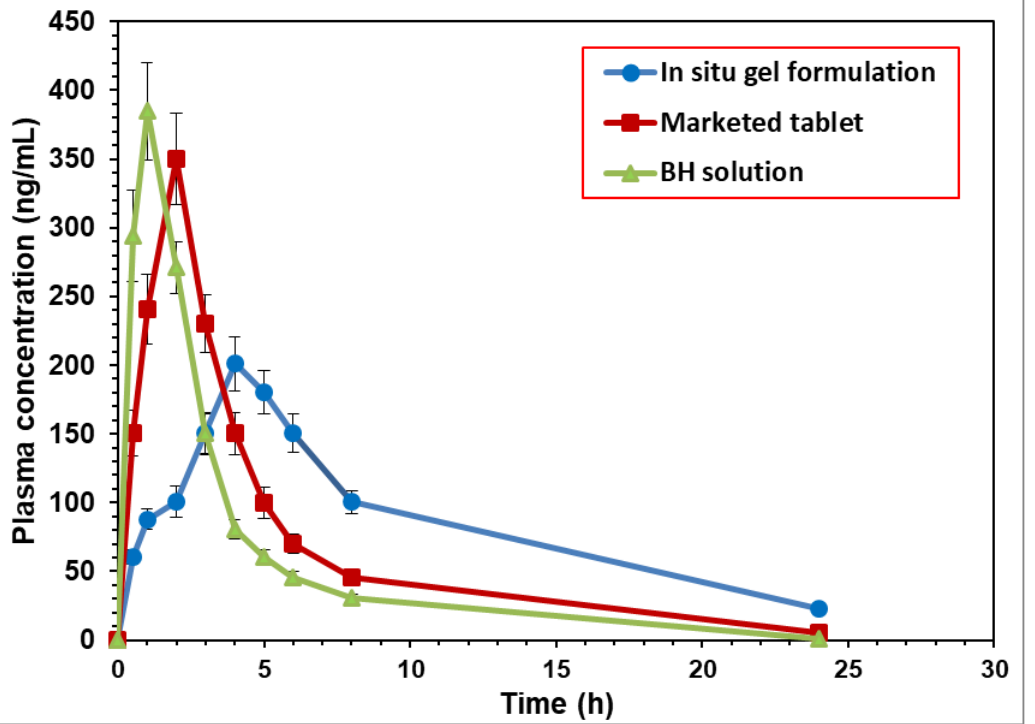
Figure 6. Mean plasma concentrations of BH after oral administration of different formulations (equivalent to 10 mg/kg) to rabbits.